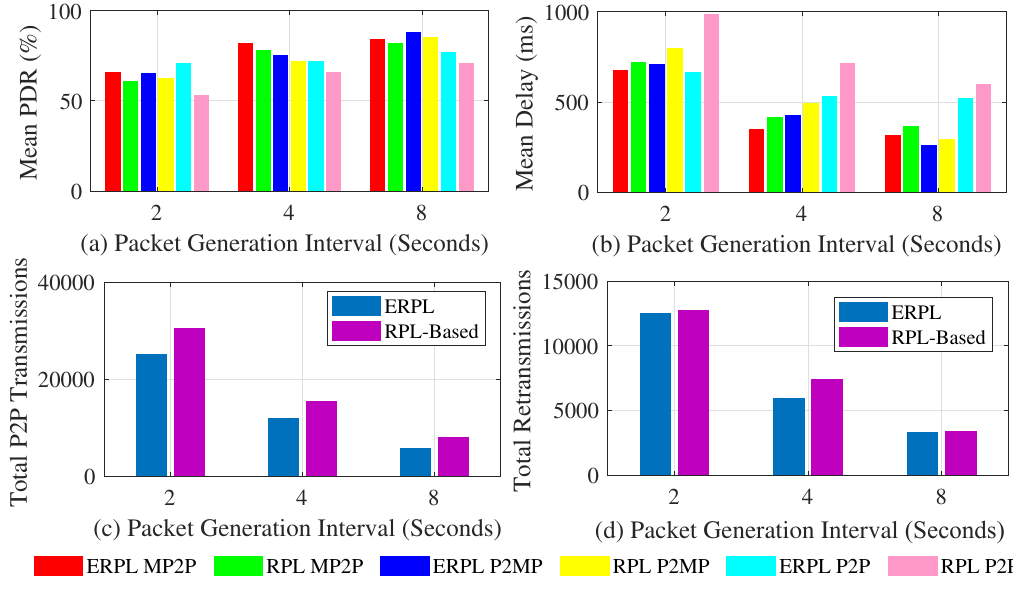
Figure 10. Protocols’ Performances in FlockLAB